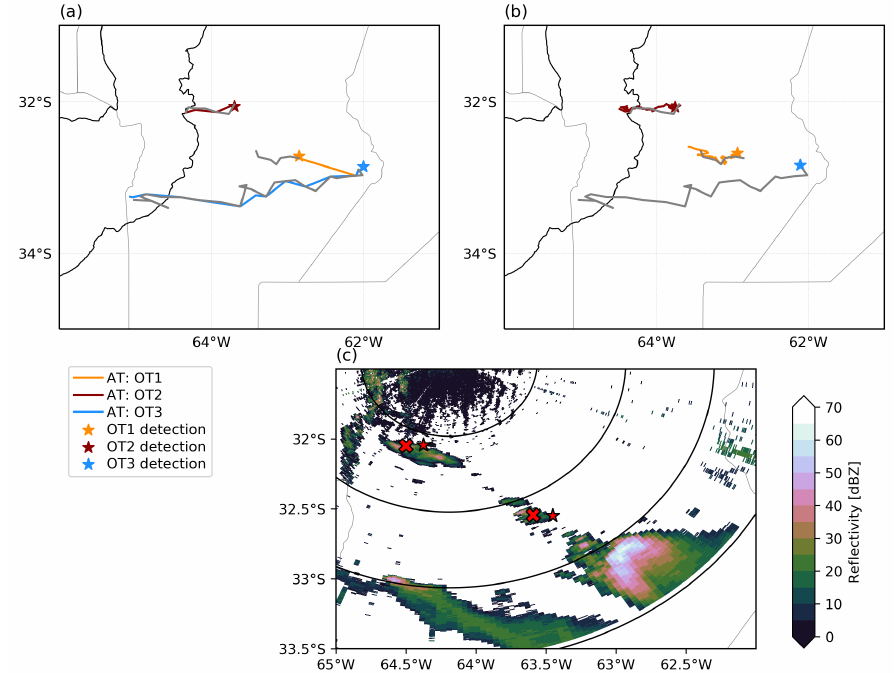
Figure 15. ( a ) Tracking trajectories for the three OTs detected in 10 November 2018 with 30 min (colors) and 15 min (gray) resolution. ( b ) Tracking trajectories for the three OTs with 1 min (colors) and 15 min (gray) resolution; 500 m height above sea level is added in black solid contour. ( c ) RMA1 ground weather radar reflectivity and parallax-corrected estimated positions of OT1 and OT2 convective systems initiations for 1 min (red cross) and 15 min (red star) resolution tracking. Each black ring denotes 60 km range from the radar site in